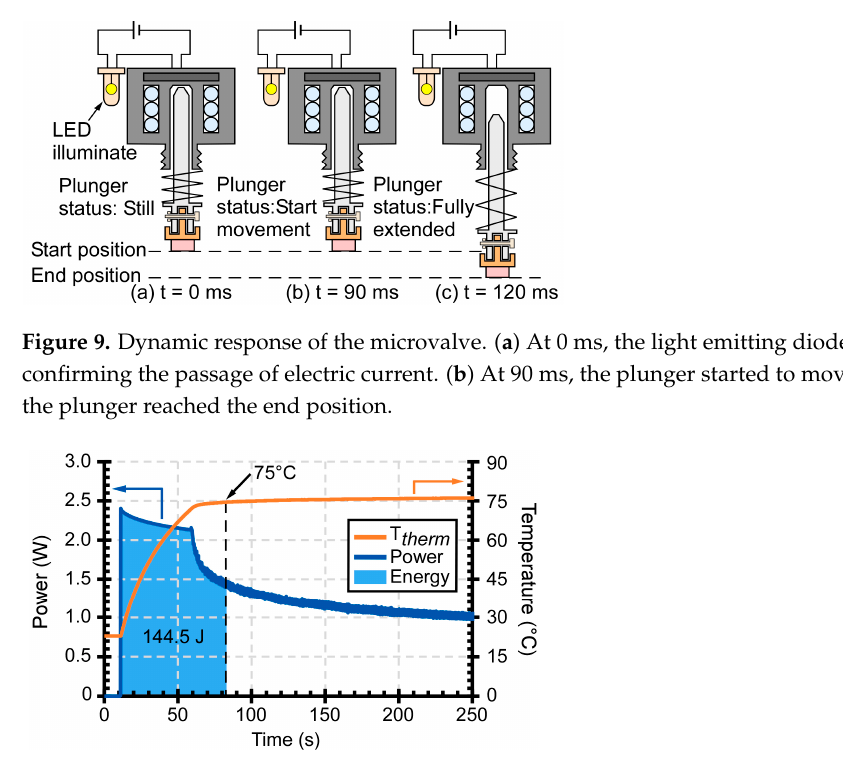
Figure 10. The energy and power consumption of the microvalve module during heating. The microvalve was heated to and maintained at 75 °C under servo control.